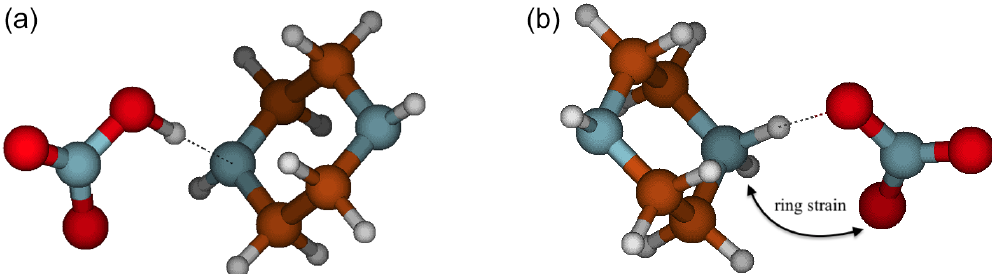
Figure 6. Deprotonated (a) and protonated (b) conformers of PZ for the NA–PZ salt showing the ring strain necessary to form another intermolecular hydrogen